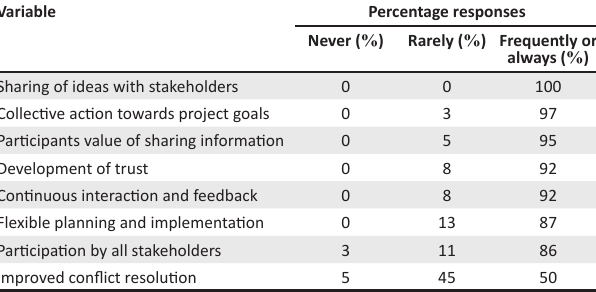
TABLE 2: Presence of personal factors that promoted social